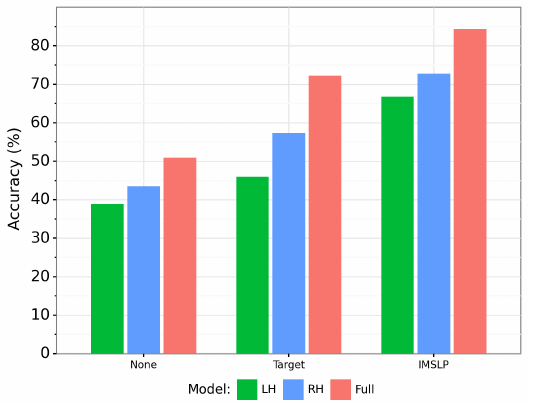
Figure 8. Comparison of GPT-2 model on fragment classification using left hand information only (green bars, leftmost in each group), right hand information only (blue bars, center in each group), and information from both hands (red bars, rightmost in each group). The three groups of bars correspond to different pretraining conditions.